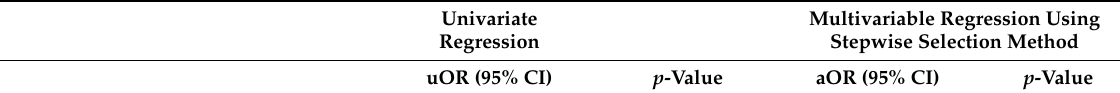
Table 2. Unadjusted and adjusted logistic regression analysis of gene-x-drug interaction and association with 90-day readmission among patients prescribed a CPIC medication within 30 days of hospital admission (N =